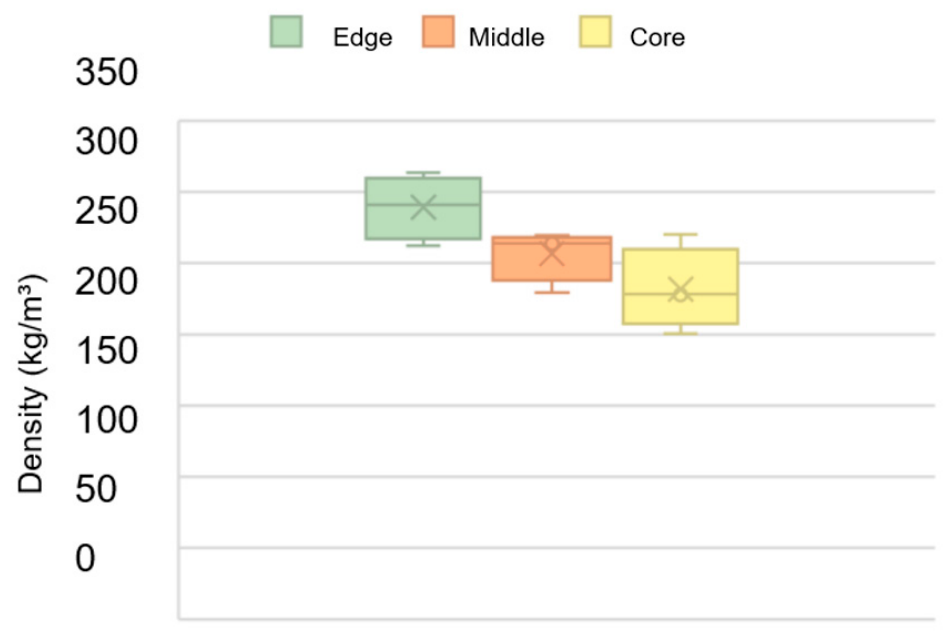
Figure 7. Density of Paulownia samples depending on the position in the cross-section (edge, middle, core)